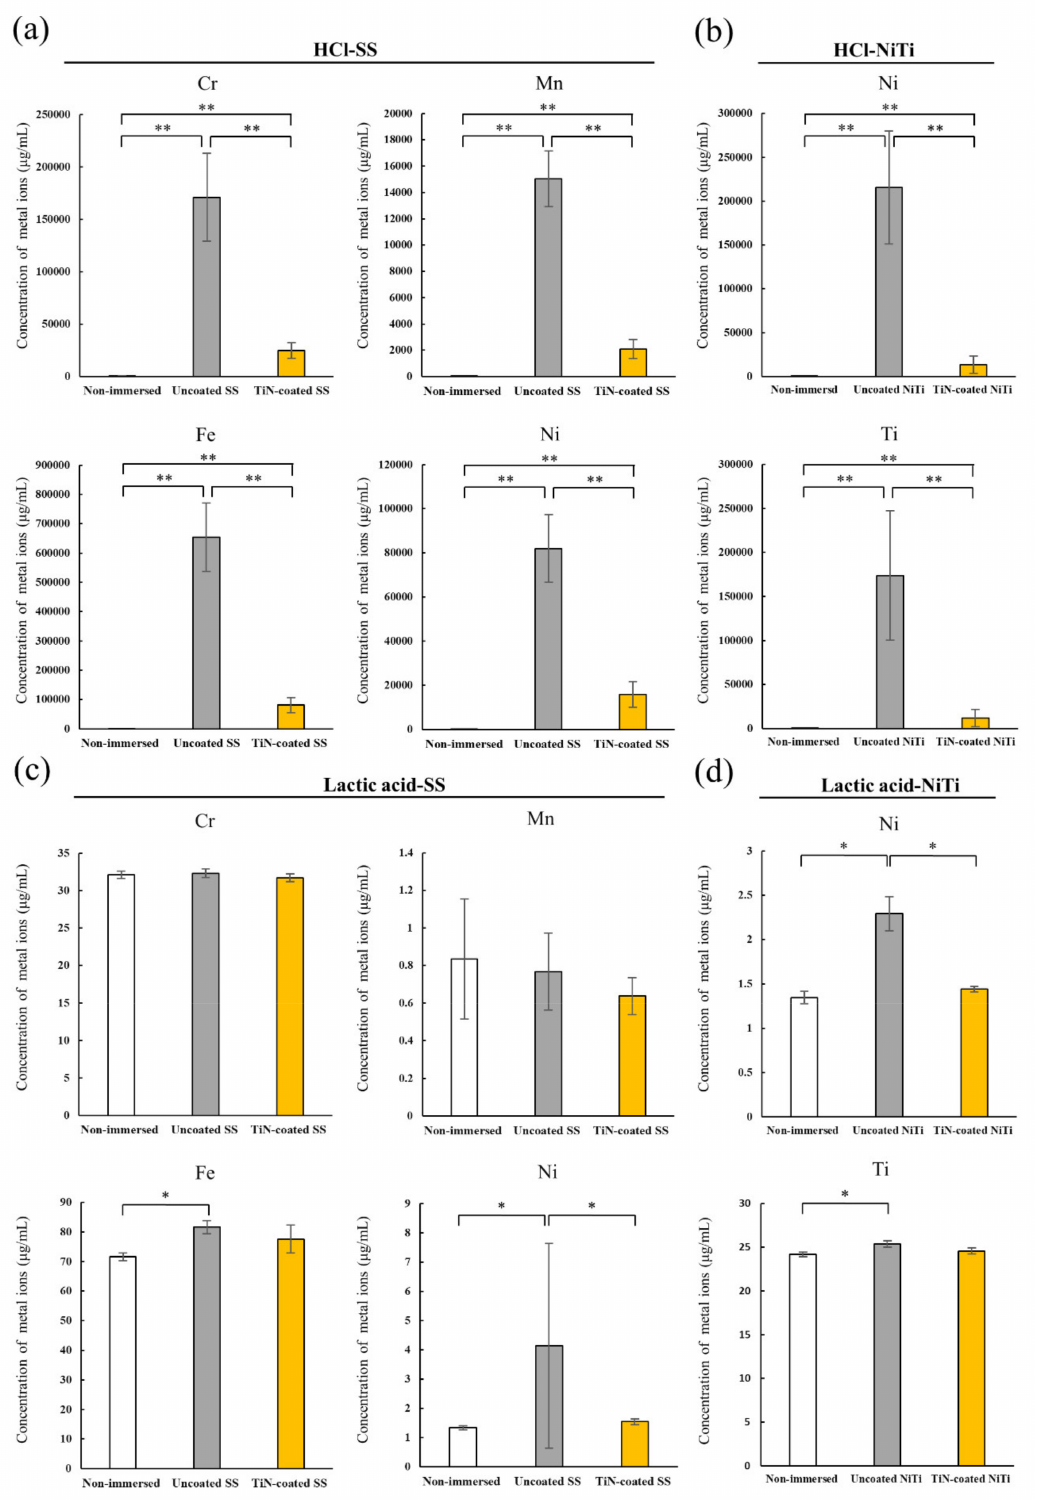
Figure 1. Metal ions released from orthodontic arch wire immersed in different solutions. After immersion in HCl or lactic acid solution for 30 min, the amount of metal ions eluted from the wire was determined by ICP-MS. The concentrations of the eluted metal ions from TiN-coated SS wire and uncoated SS wire were: ( a ) SS immersed in HCl; ( b ) NiTi immersed in HCl; ( c ) SS immersed in lactic acid; ( d ) NiTi immersed in lactic acid. The statistical significance of differences was determined by the Shapiro-Wilk (* p < 0.05, ** p <